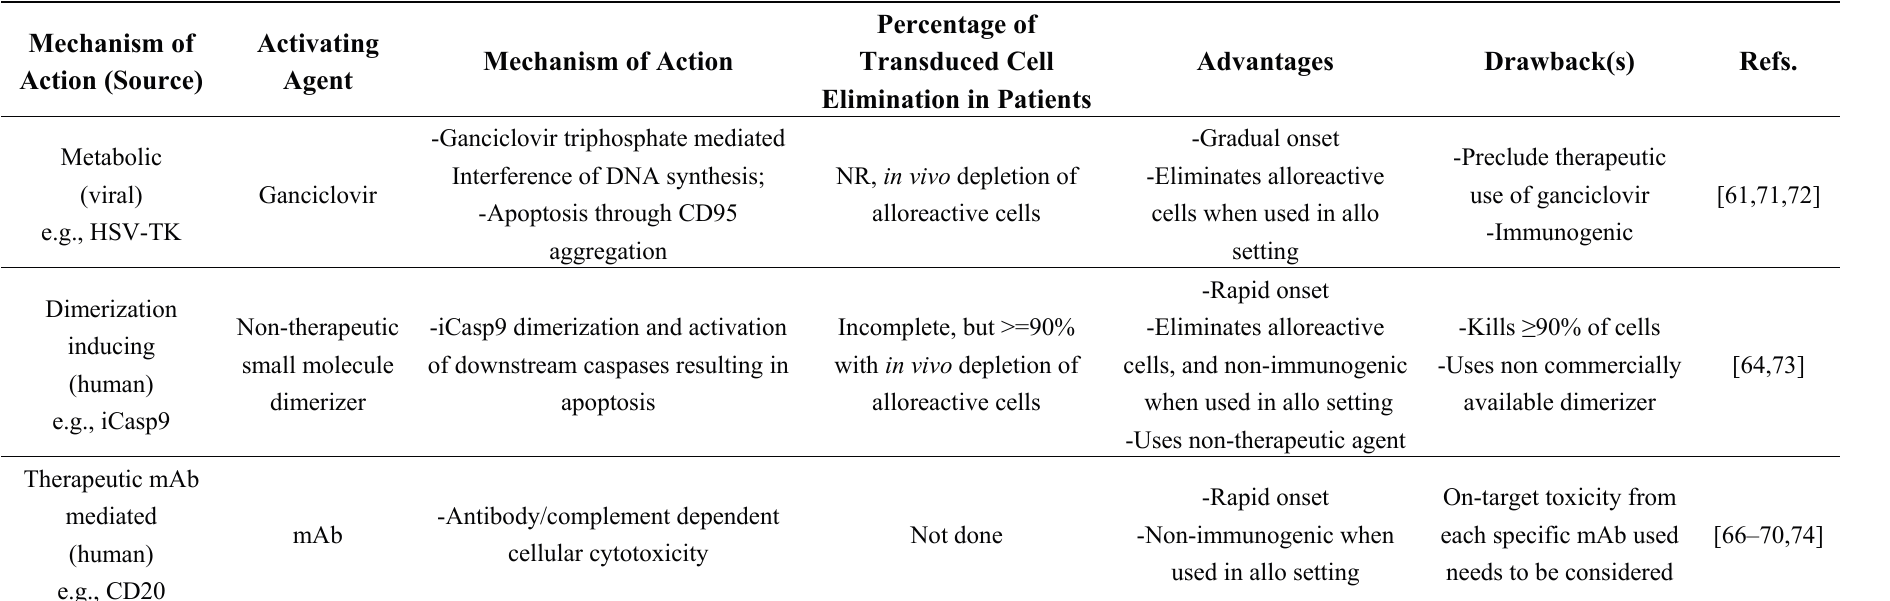
Table 1. Classification and main characteristics of suicide gene